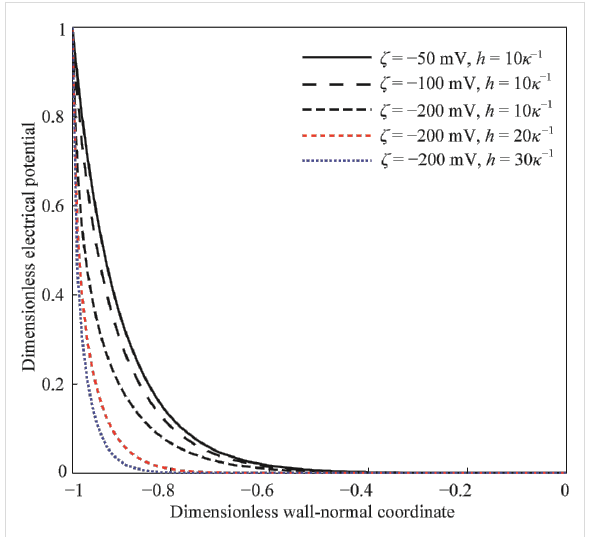
Figure 2: The dimensionless electrical potential as a function of dimensionless wall-normal coordinate in the non-overlapping EDL.